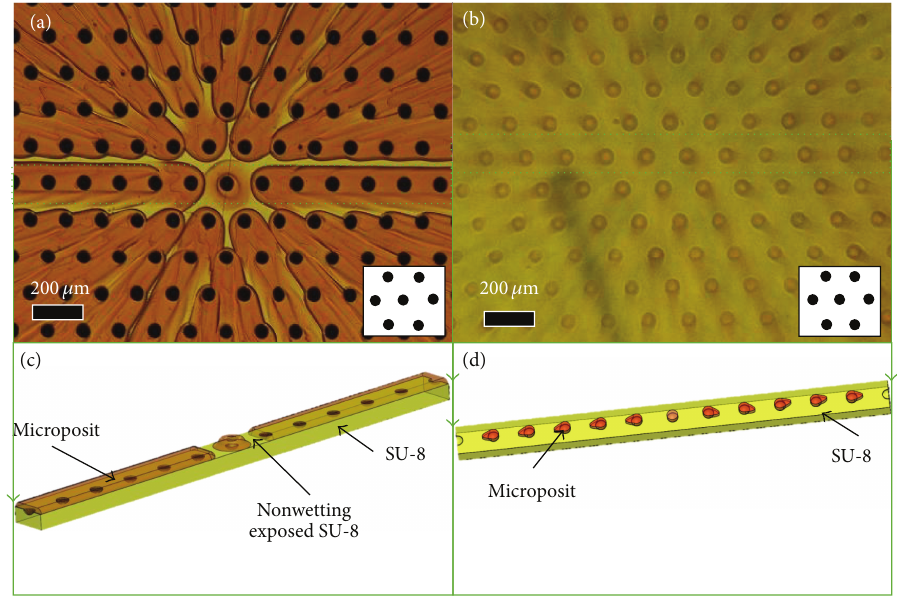
Figure 1: Optical images of Microposit on PEB SU-8 2050 (a) before development (b) after development. Inset shows the mask employed for UV exposure. Figures (c) and (d) represent an isometric view of the sample.